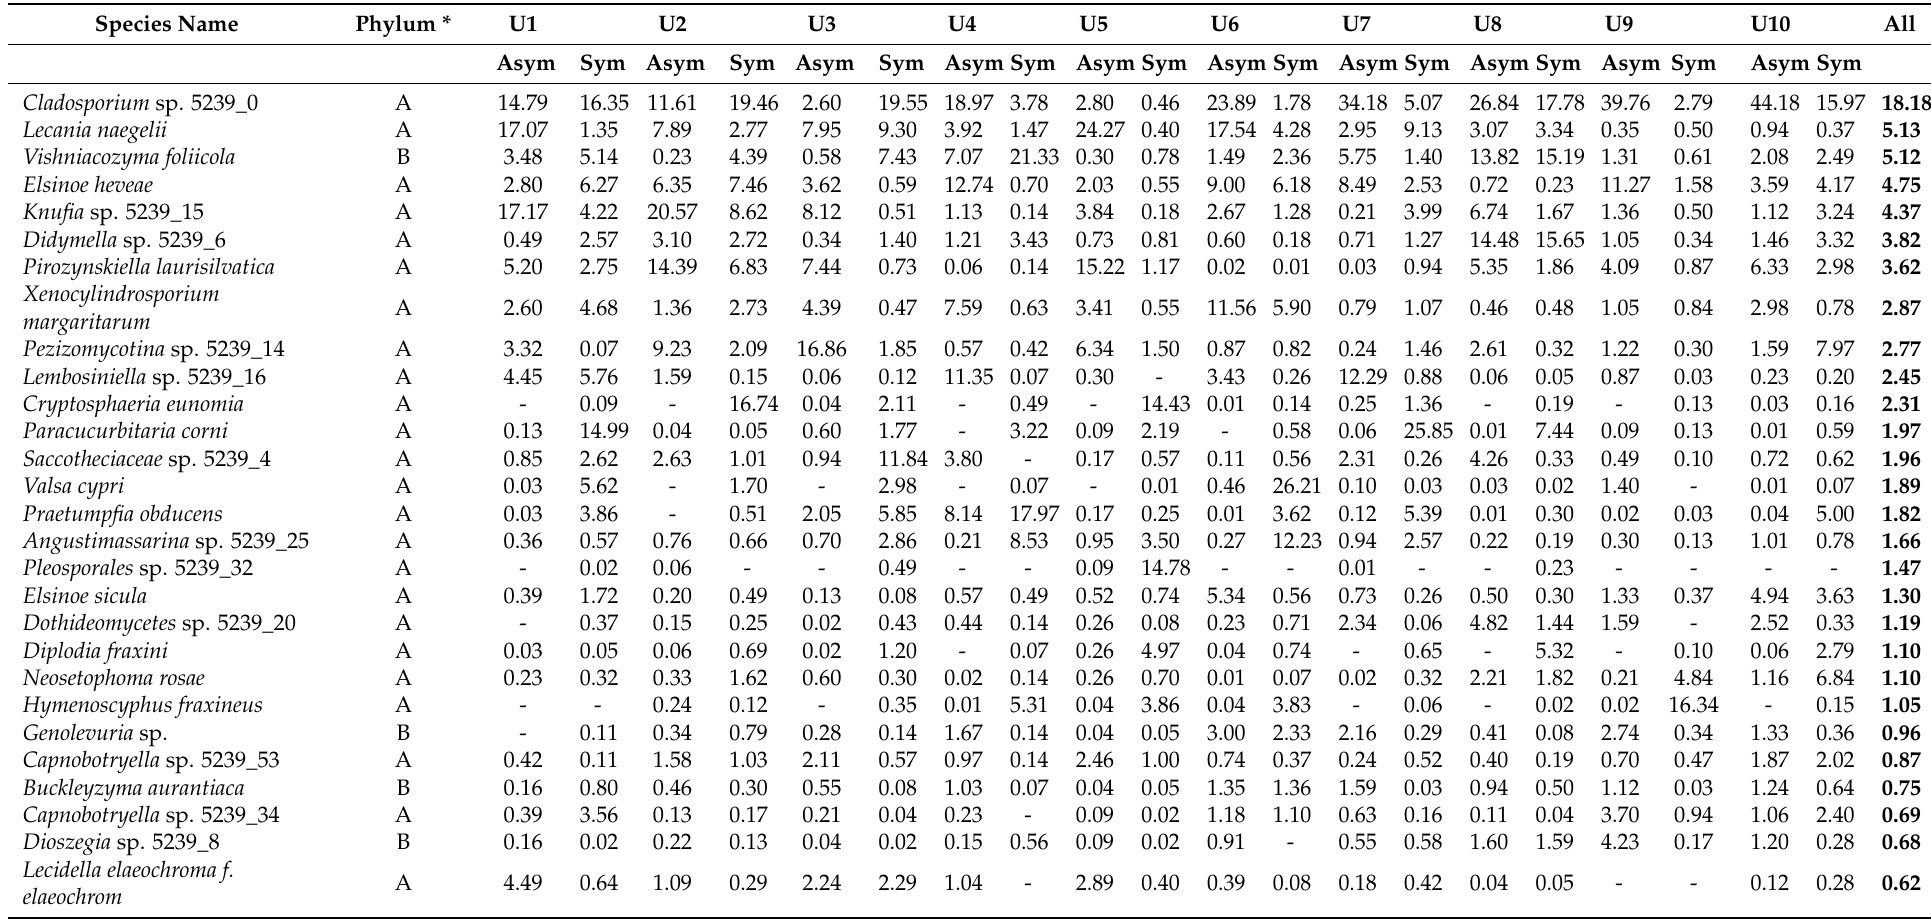
Table 5. Occurrence and relative abundance (%) of the 40 most common fungal taxa (shown as a proportion of all high-quality fungal sequences) in asymptomatic and symptomatic shoot samples in ten populations of Fraxinus excelsior in